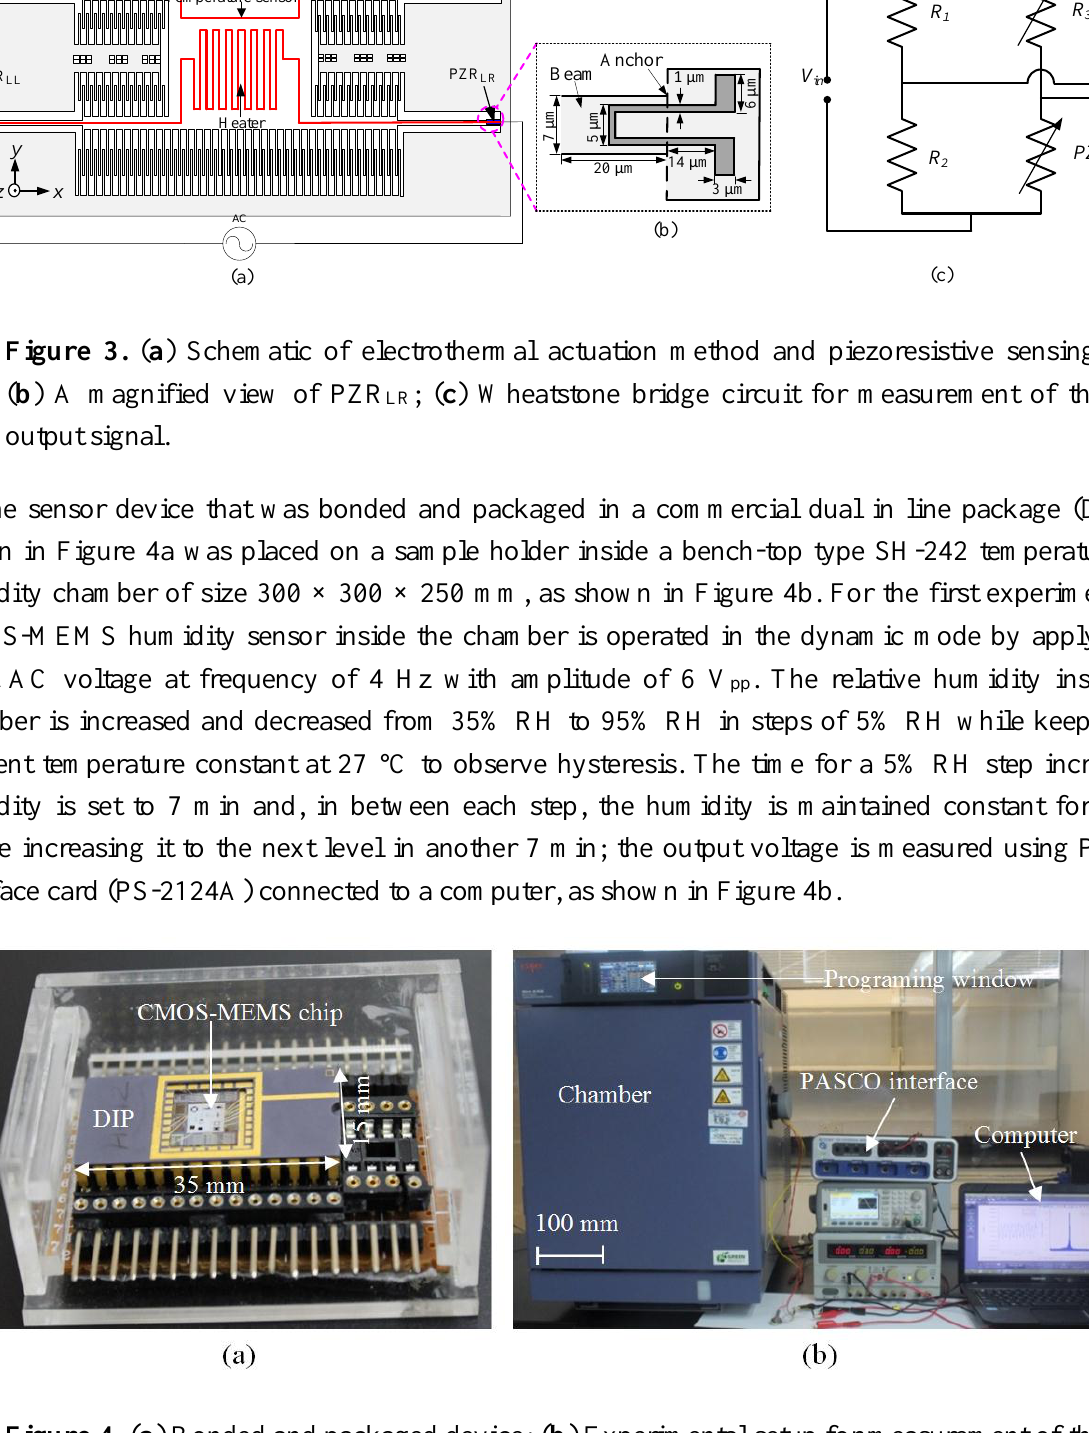
Figure 4. ( a ) Bonded and packaged device; ( b ) Experimental setup for measurement of the humidity response of the CMOS-MEMS